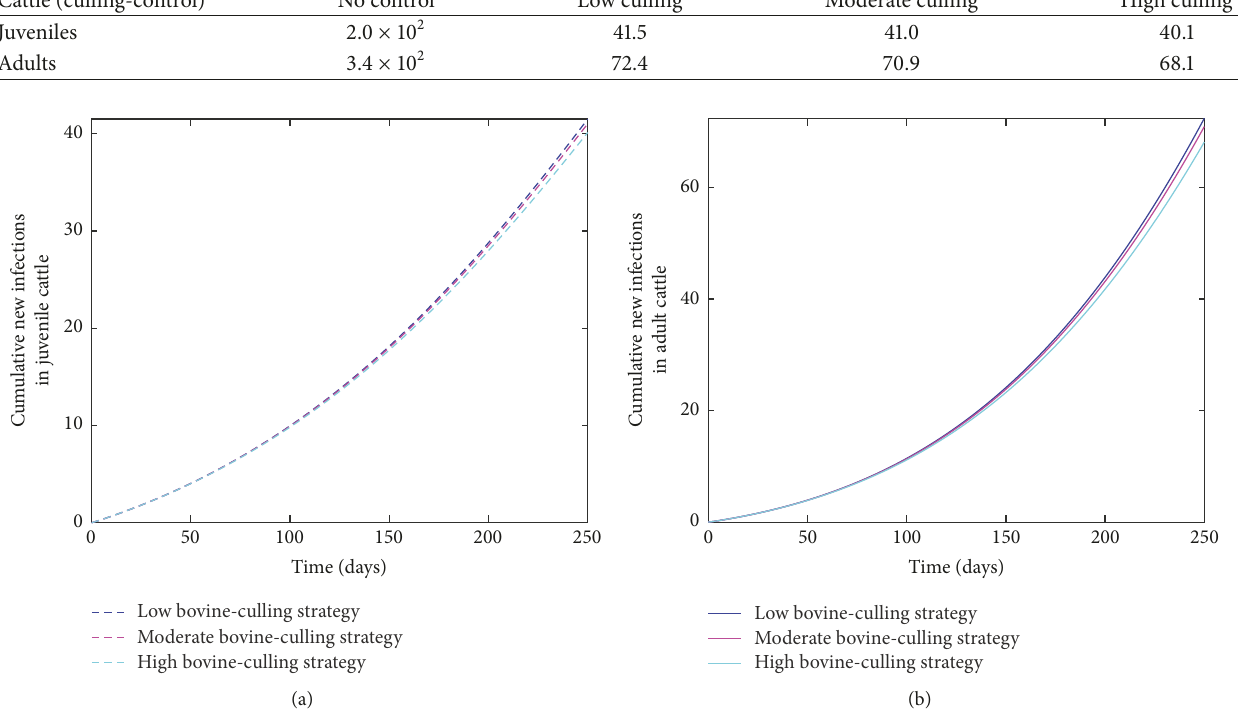
Figure 6: Simulation of the bovine anaplasmosis model (12) as a function of time using the bovine-culling strategy. (a) Cumulative new infections in juvenile cattle; (b) cumulative new infections in adult